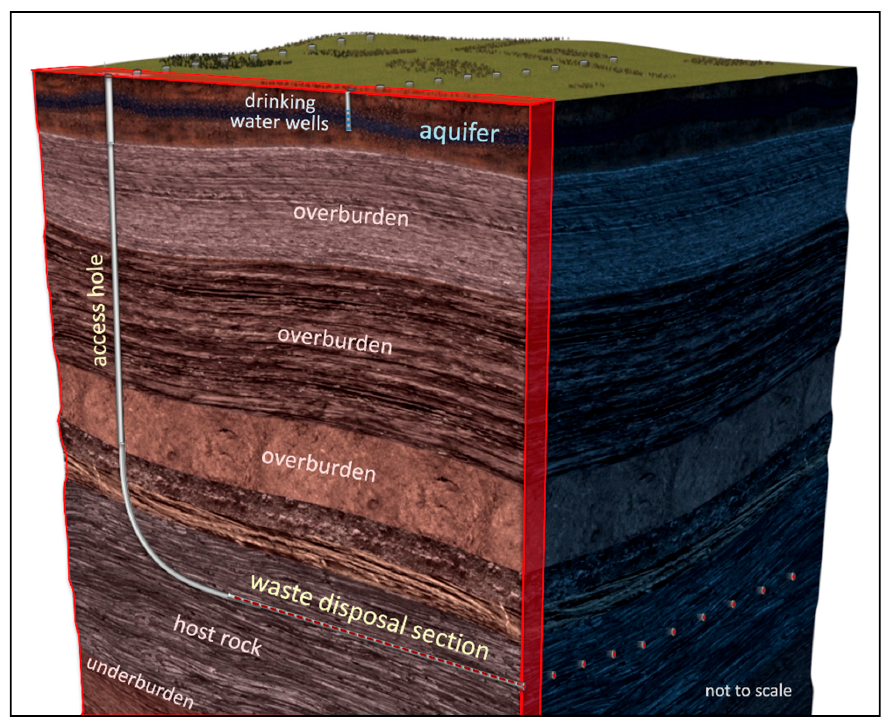
Figure 1. Schematic of a deep horizontal drillhole repository (not to scale) with vertical access hole, gradually turning horizontal. The near ‐ horizontal waste disposal section holds the canisters. A repository may consist of multiple drillholes; the red ‐ shaded box indicates a symmetry cell.